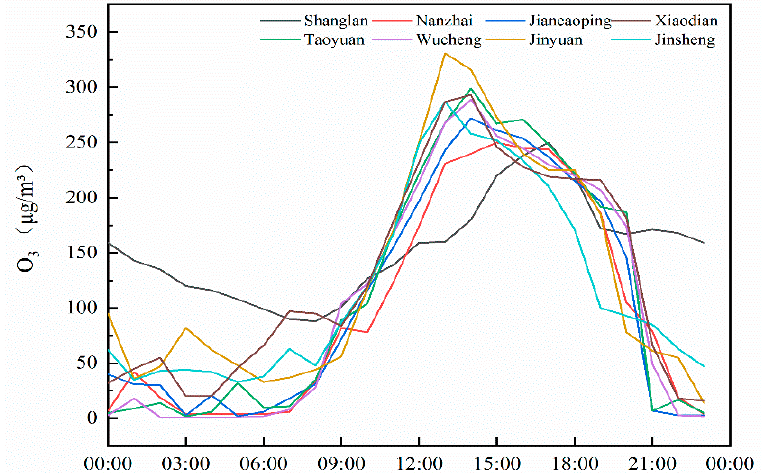
Figure 7. Time di ff erence of peak ozone concentrations at each site on 23 June Figure 7. Time difference of peak ozone concentrations at each site on 23 June 2018. Figure 7. Time difference of peak ozone concentrations at each site on 23 June 2018. Figure 7. Time difference of peak ozone concentrations at each site on 23 June 2018.